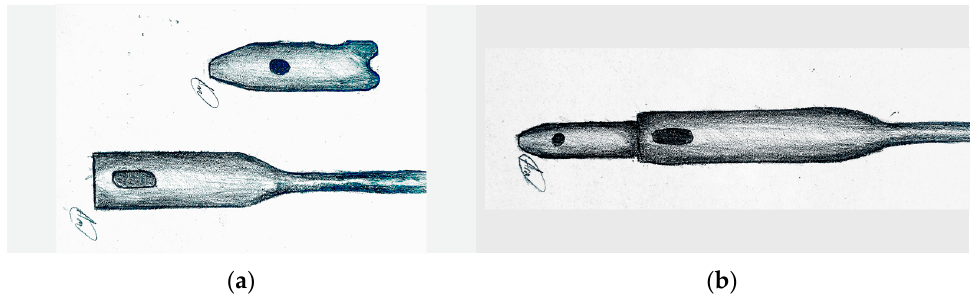
Figure 15. The closed cerclage wire pull-out technique for solid non-cannulated nail implants. ( a ) Distal nail piece and cylinder hole; ( b ) Cylinder hole inserted over distal nail piece till the wholes are aligned. Removing solid nails is a complex task that requires skill and experience. The success rate is lower, and complications can occur. The alignment of the cylinder with the nail